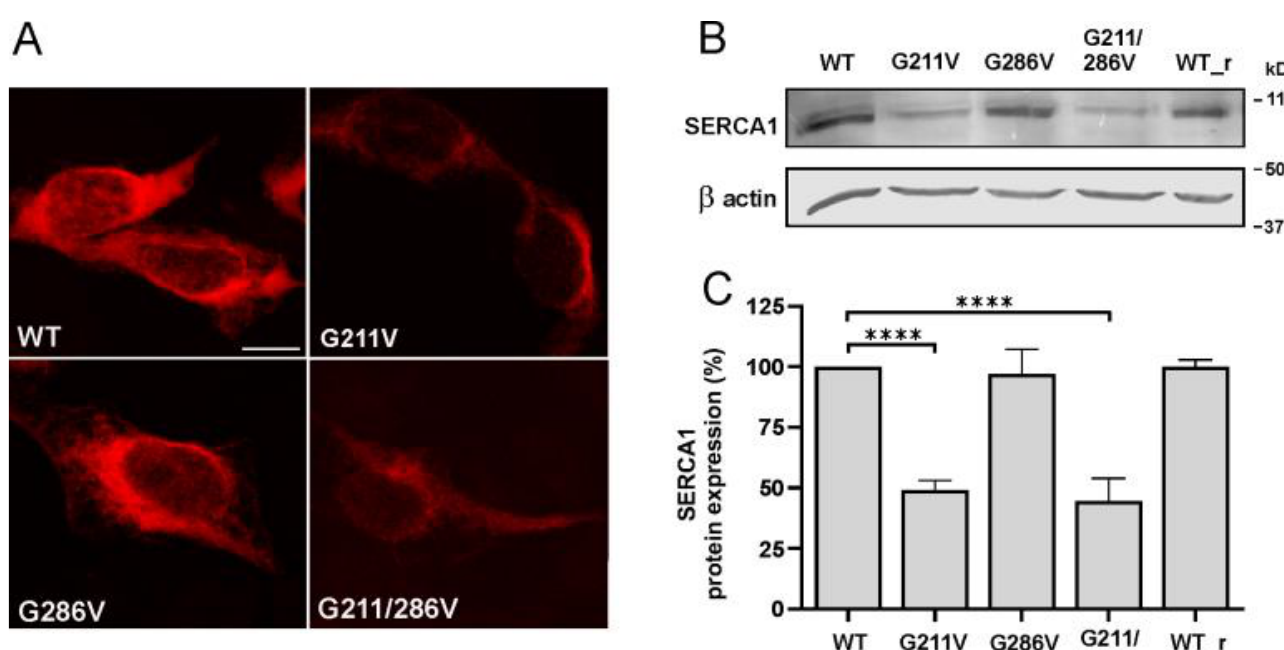
Figure 1. Cellular localization and expression level analysis of SERCA1 protein in HEK293 cells transfected with WT and mutant SERCA1 constructs. Cells were transfected with WT SERCA1 cDNA of bovine or rabbit (WT_r) origin, or with G211V, G286V and G211/28164H-mutated SERCA1 cDNAs, as indicated. ( A ) Transfected cells were immunolabelled with monoclonal antibodies to SERCA1 and then incubated with the appropriate secondary antibody (red fluorescence). Images were recorded at the same setting conditions and magnification (scale bar 25 µ m). ( B ) Total protein lysates from cells transfected with WT or mutated SERCA cDNAs were obtained by solubilization. An equal quantity of protein was separated by SDS-PAGE and blotted onto nitrocellulose paper. The blots were incubated with antibodies specific for SERCA1 and the 42 kDa beta-actin, used as a loading control. A representative Western blot is shown. ( C ) Quantification of SERCA1 protein bands performed by densitometric analysis on Western blots. Data (mean values from at least four independent experiments ± S.D.) are reported as the percentage of values from WT SERCA1 of bovine origin. Statistical analysis was performed by the one-way ANOVA test, followed by Dunnett’s multiple comparisons test. **** p ≤ 0.0001.